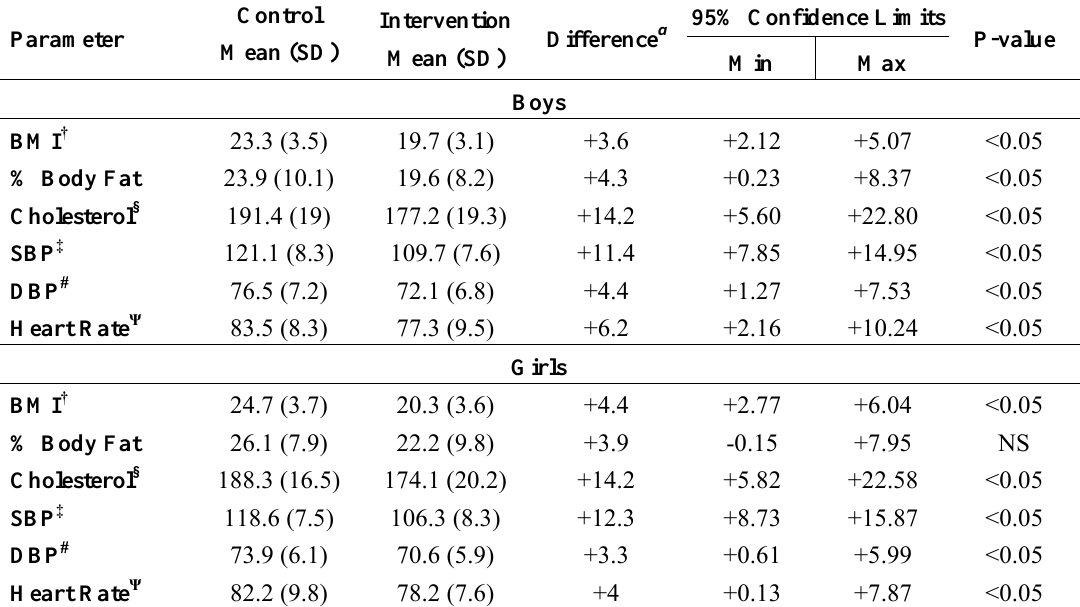
Table 2. Anthropometric and physiological parameters of control and intervention pupils by gender after 3 months.